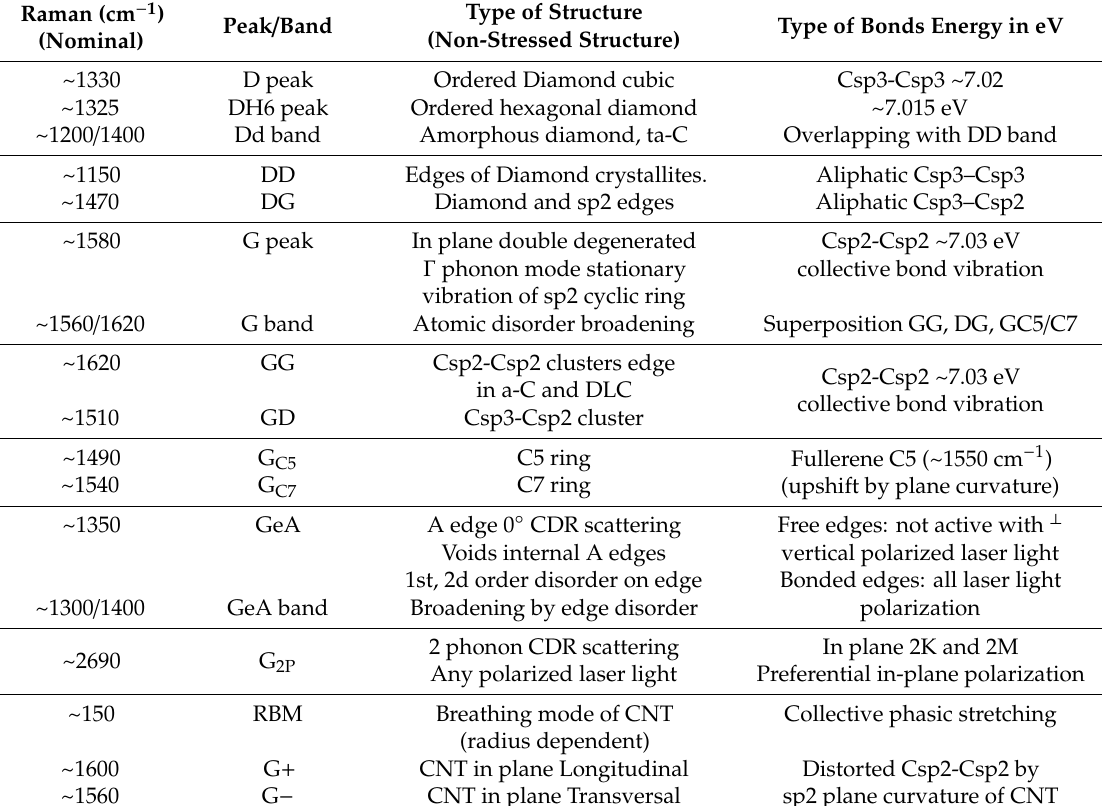
Table 1. Raman nomenclature for carbon material